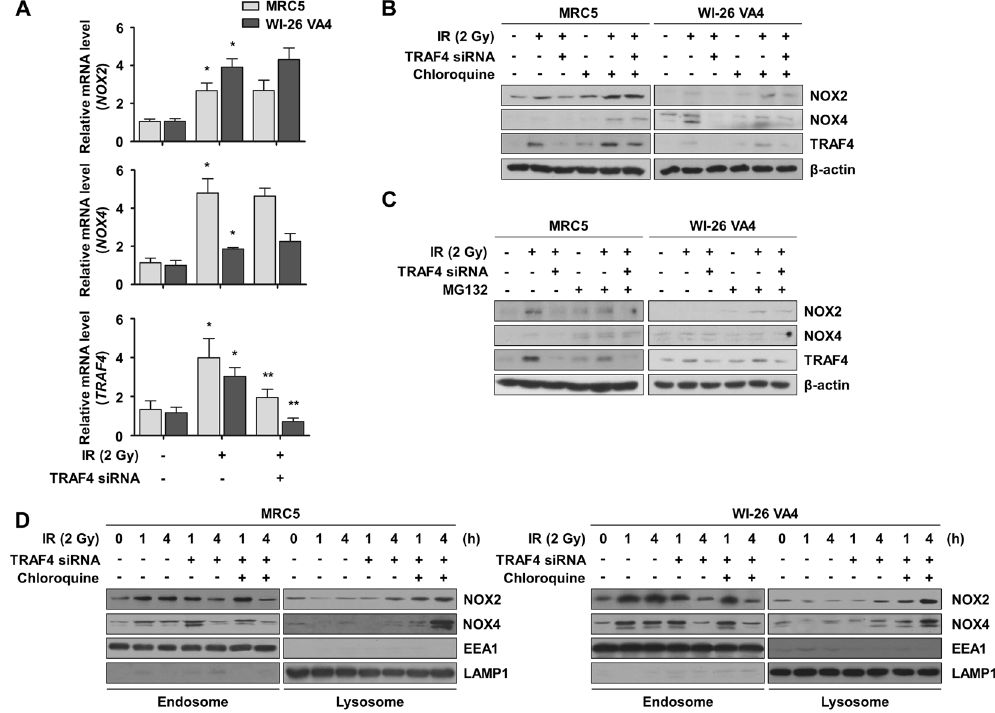
Figure 3. Radiation-induced NOX2 and NOX4 were stabilized by TRAF4 in endosomes. ( A ) The effects of knockdown of TRAF4 on radiation-induced mRNA levels of NOX2, NOX4, and TRAF4 were assessed by qRT-PCR. Error bars, ± SEM (n = 3); * p < 0.05 compared with non-irradiated cells, ** p < 0.05 compared with irradiated cells. ( B ) Alterations of protein levels of NOX2 and NOX4 upon inhibition of lysosomal degradation were assessed by Western blotting. Cells were treated with Chloroquine, an inhibitor of lysosomal degradation, for 30 min prior to irradiation. ( C ) Alterations of protein levels of NOX2 and NOX4 upon inhibition of proteasomal degradation were assessed by Western blotting. Cells were treated with MG132, an inhibitor of proteasomal degradation, for 30 min prior to irradiation. ( D ) Effects of Chloloquine on protein stability of NOX2 and NOX4 in endosomes or lysosomes were measured by Western blotting. Endosome/lysosome fractionation was conducted after irradiation (1 h or 4